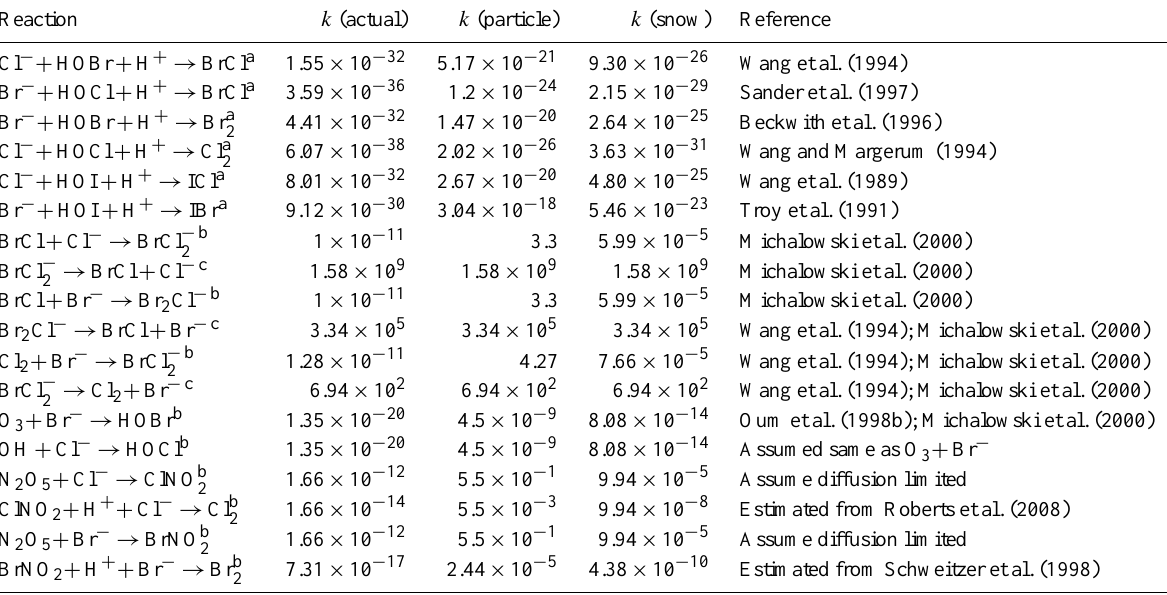
Table 4. Aqueous-phase reactions in the model. All aqueous reaction rate constants are converted to units consistent with the gas-phase reactions to be read by the modeling program.